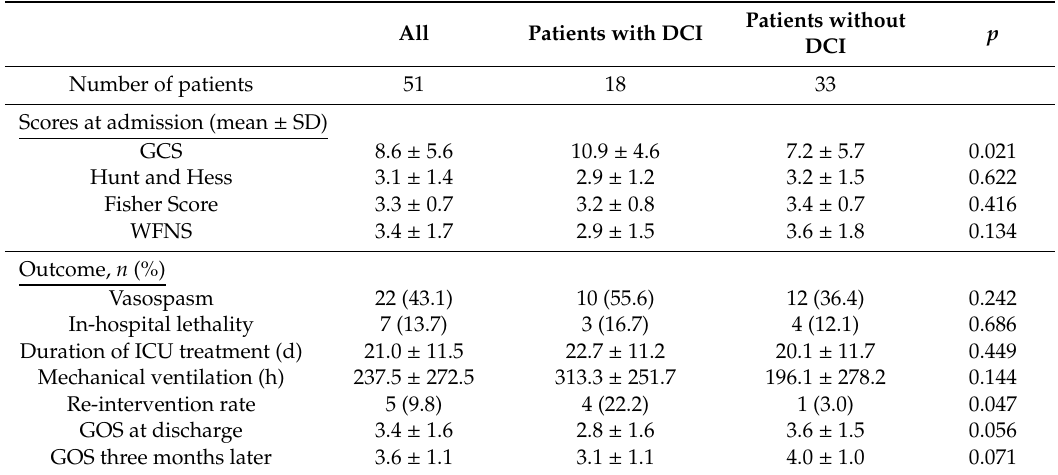
Table 2. Clinical scores and outcome of SAH patients with or without DCI.